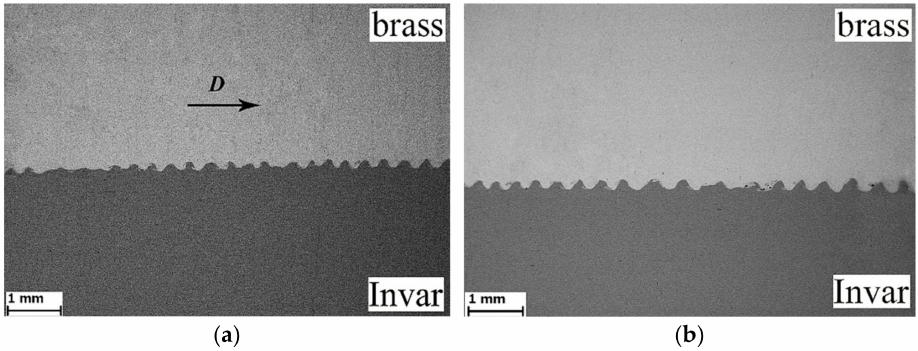
Figure 2. SEM images of the weld interface of brass (CuZn37) and Invar 36 after EW: ( a ) initial part; ( b ) final part; arrow D shows the detonation direction.